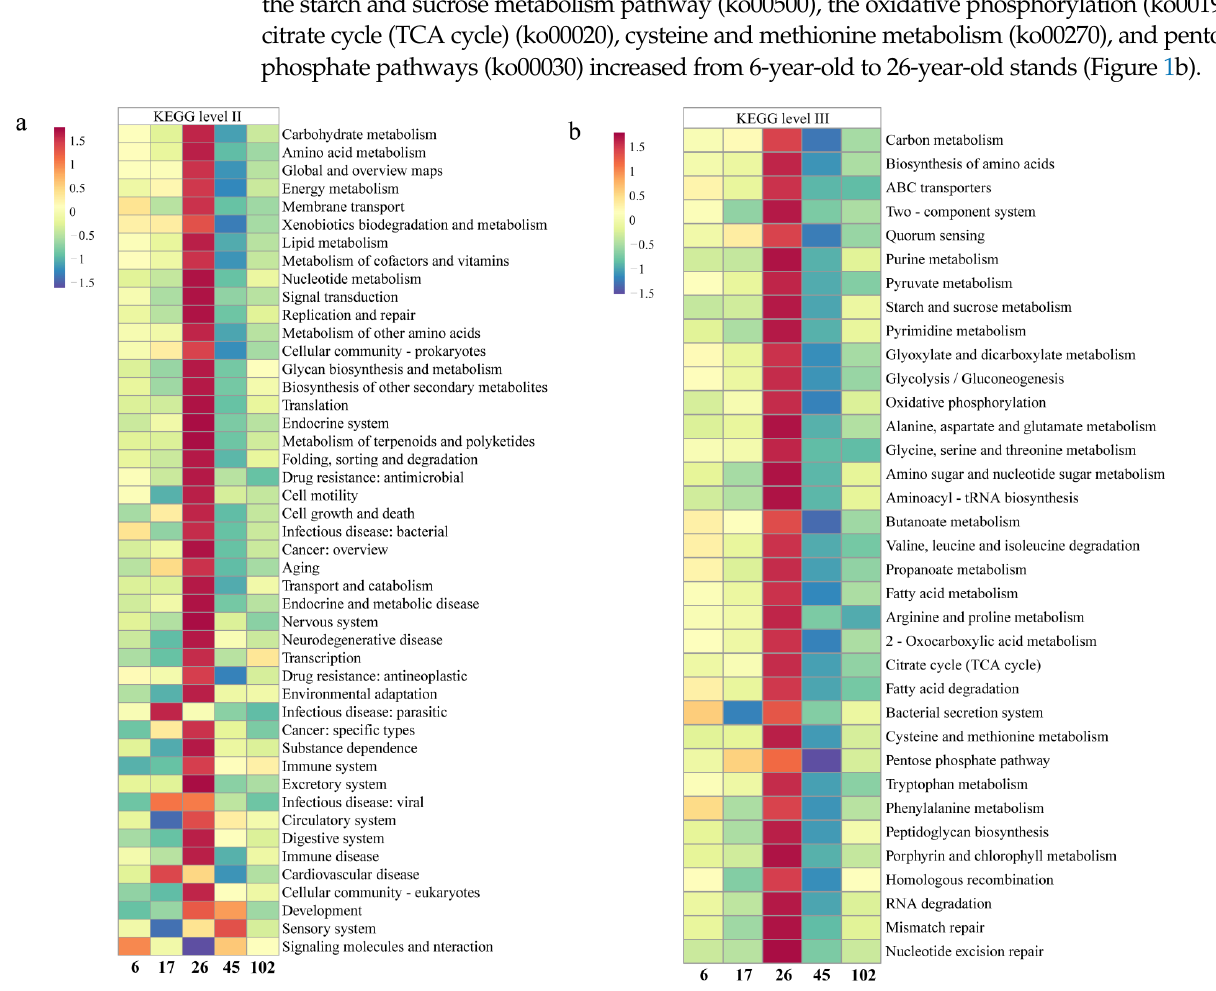
Figure 1. Heatmap of KEGG pathway function annotation ( a ) at level 2 and ( b ) dominated functions at level 3 in rhizosphere soil of Chinese fir plantations at five different stand ages. Generally, the compositions of the rhizosphere microbial community were closely related to the different stages of Chinese fir plantations (Figure 2). The relative abundance of Actinobacteria increased significantly from 6- to 26-year-old stands but reduced for 45- year-old stands, with a recovery at 102-year-old stands. The relative abundance of Planc- tomycetes was significantly high in 17-year-old stands (Figure 2b). In the fungal commu- nity, the relative abundance of Basidiomycota increased with the age gradient and was abundant in 45-year-old plantations (Figure 2c). Thaumarchaeota had the highest relative abundance in the 102-year-old Chinese fir stands among the archaeal community (Figure 2d) . The relative abundance of phylum Euryarchaeota increased from young stands (6 years) to middle-aged stands (17 years) but decreased as the stands aged. Conversely, the relative abundance of Crenarchaeota reduced until 26 years of age for the plantation stands. The Shannon index of the archaeal community showed the lowest value in 102-year-old Chinese fir plantations (Table S1).